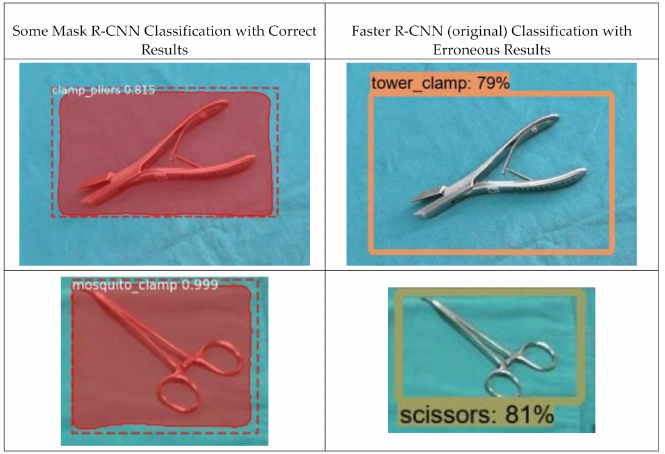
Figure 9. Examples of instruments correctly identified by Mask R-CNN but mis-identified at least once by Faster